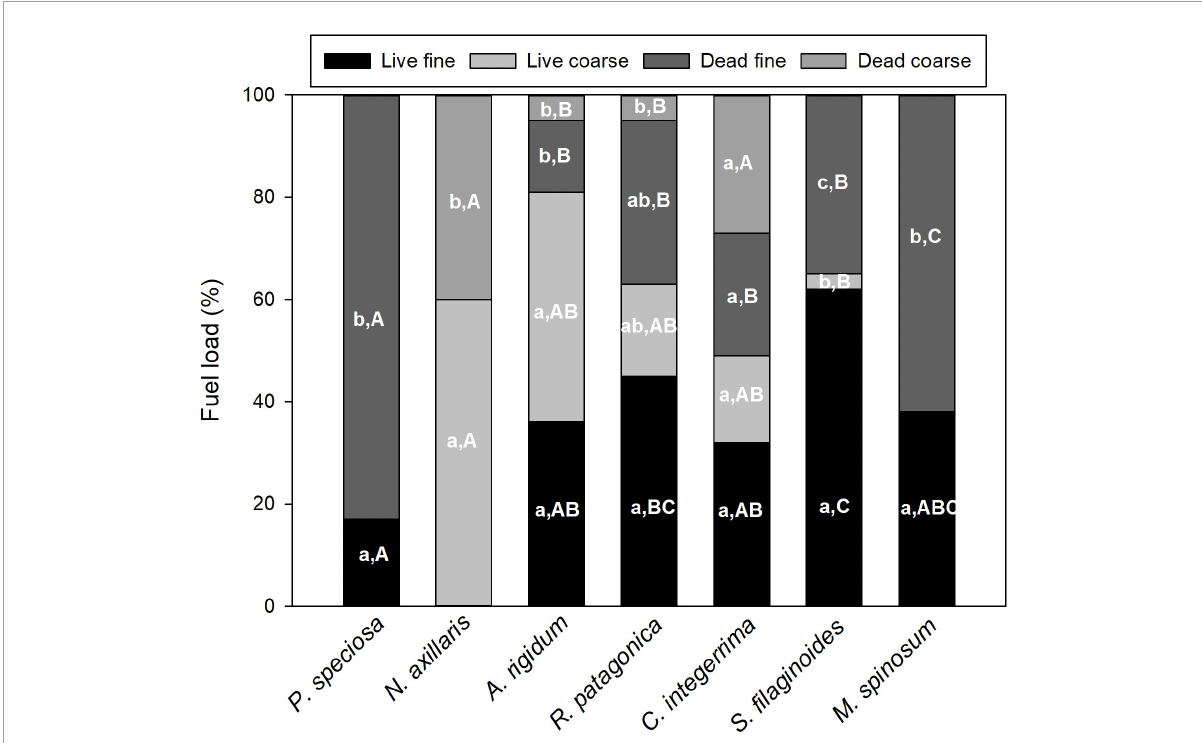
FIGURE5 Mean percentage ± SD of live fine and coarse, and dead fine and coarse fuel load of dominant species. Different lower-case letters indicate significant differences in the same species, whereas upper-case letters represent significant differences among species ( P < 0.005).